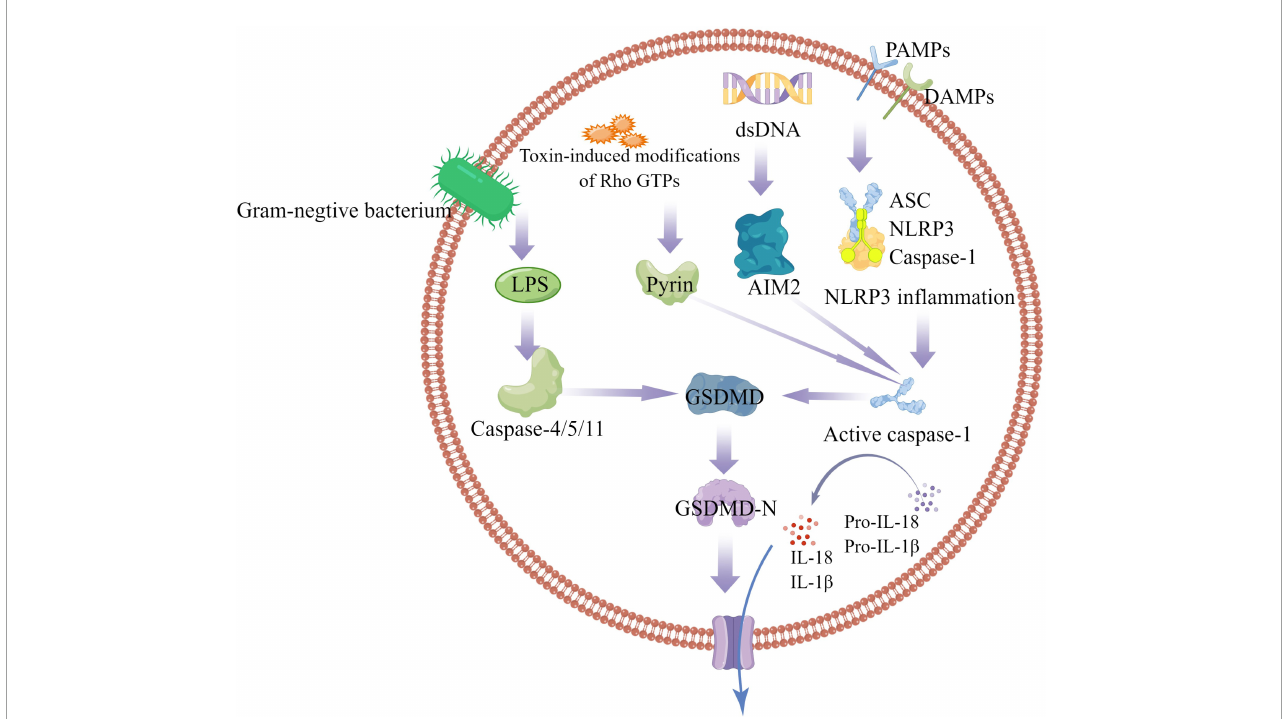
FIGURE1 Caspase-1-dependent and independent inflammatory pathways. In the caspase-1-dependent pyroptotic pathway, cells undergo pathogen-associated molecular patterns (PAMPs) and harm-associated molecular patterns (DAMPs) (including NLRP3, AIM2, or pyrin); NLRP3 oligomerizes and recruits ASC and procaspase-1, triggering caspase-1 activation and maturation and secretion of proinflammatory cytokines IL-1 β and IL-18. GSDMD-N is formed by the cleavage of inflammatory caspases, mediates the reorganization of cell membrane structure, and promotes the release of inflammatory factors, cell swelling and cell death. In the caspase-1-independent pyroptosis pathway, Gram-negative bacterial cell wall component LPS activates the caspase-4/5/11 pathway to mediate